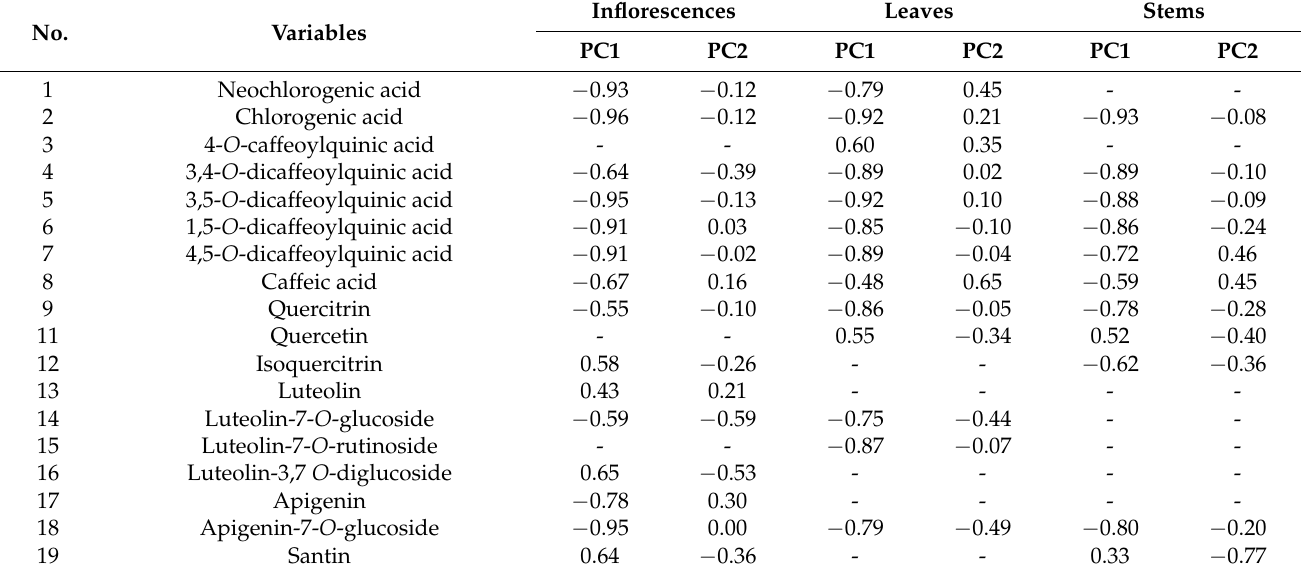
Table 4. PCA1 results based on Pearson correlation matrix between selected Achillea millefolium phe- nolic compounds in plant organs that differed significantly between countries and the two principal component